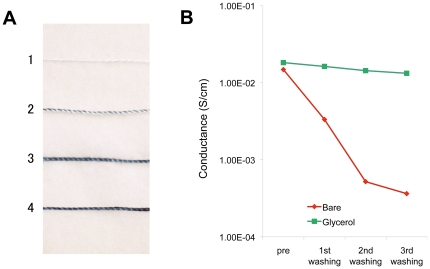
Glycerol enhanced water sturdiness of PEDOT-PSS silk thread.A. Photograph of the threads soaked in water for three days. 1) Pristine silk thread. 2) PEDOT-PSS silk thread without glycerol. 3) PEDOT-PSS silk thread with glycerol. 4) PEDOT-PSS silk thread without water soaking. B. Repeated cycles of washing with water and drying impaired the electrical conductivity of the PEDOT-PSS silk thread. The conductance of PEDOT-PSS silk thread (red line) and glycerol treated PEDOT-PSS silk thread (green line) after every washing cycle are shown (measured at dry state, averaged data from 10 samples are plotted). The conductance of thread that were not treated with glycerol fell to less than 1% that of the control. Glycerol treated thread retained its conductance after the third washing.